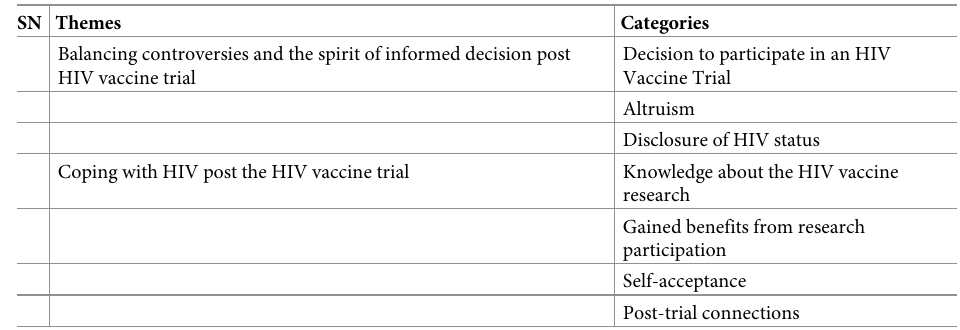
Table 2. Themes and